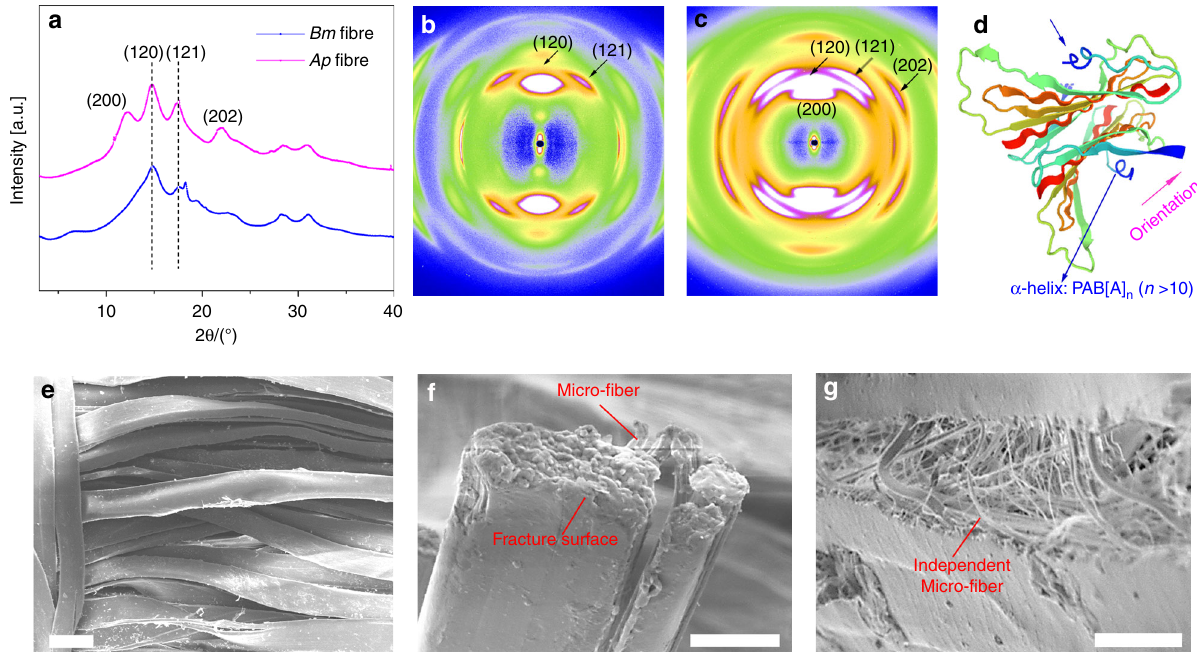
Fig. 1 Characterization of A. pernyi and B. mori silk from woven fabric. a One-dimensional WAXS pro fi le derived from the 2D WAXS patterns of silk fi bres. b , c 2D WAXS patterns of a bundle of silk fi bres. b mori silk, c A. pernyi silk. d Conformation structure of A. pernyi silk fi bre. e Surface of A. pernyi silk fi bre. f Fracture surface of A. pernyi silk fi bre after tensile test. g Side of A. pernyi silk fi bre after tensile test. Scale bars: a 50 μ m, b 10 μ m and c 20 μ